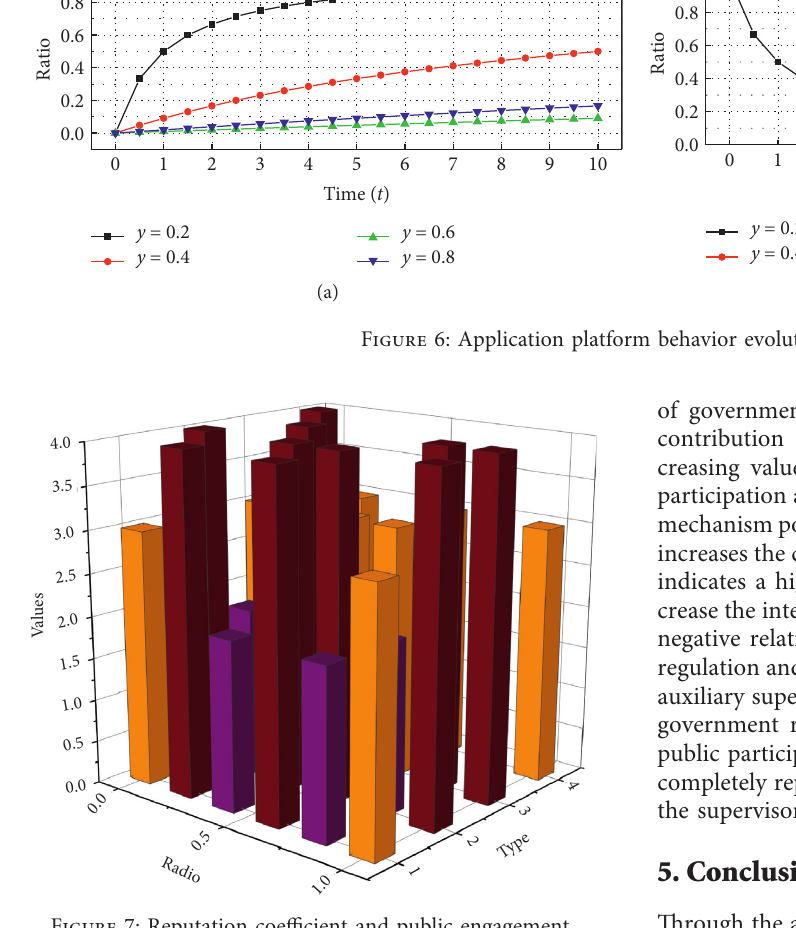
Figure 7: Reputation coefficient and public